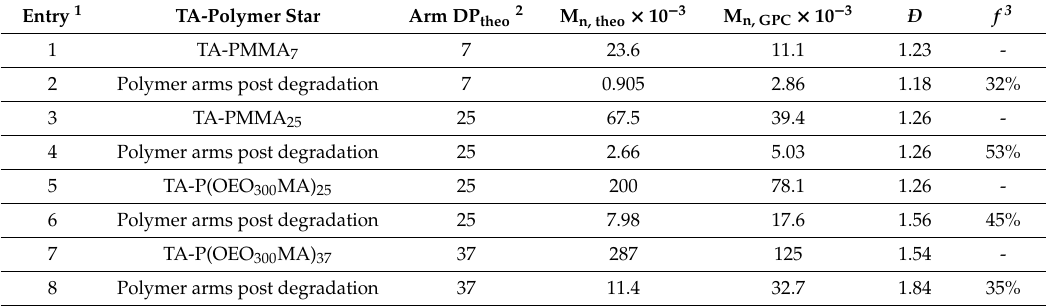
Table 1. The polymer stars prepared and degraded in either methanol/bicarb (PMMA) or water/bicarb (P(OEO 300 MA)).